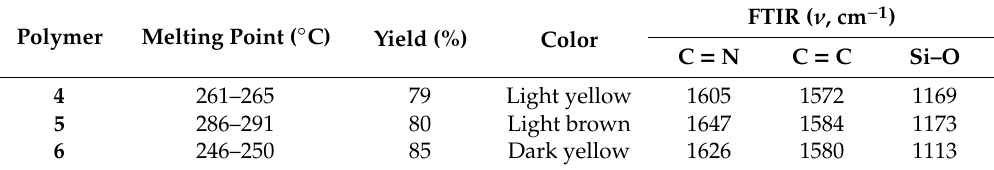
Table 3. Common FTIR absorption bands of 4–6 and their melting points, yields and color.